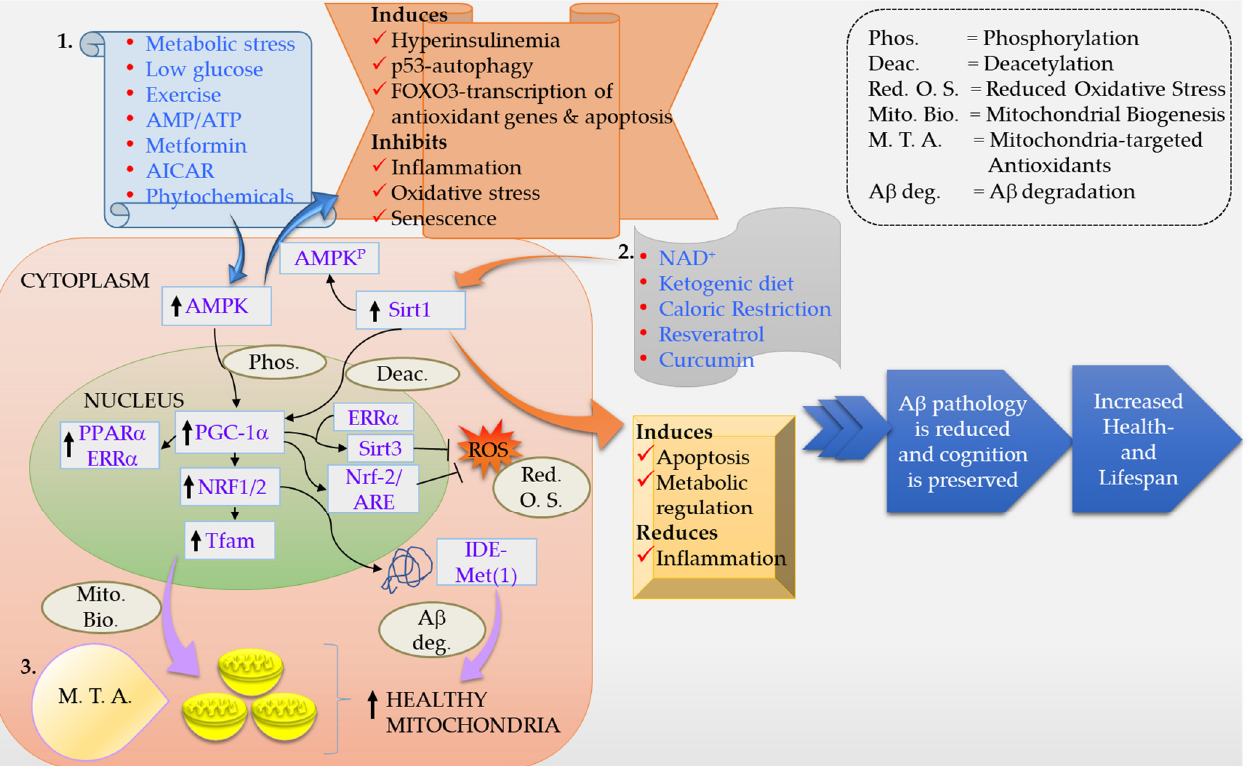
Figure 2. Schematic representation of various factors and processes involved in the mechanism of neuroprotection in AD. Various therapeutic approaches and physiologic and extracellular signals are shown in boxes 1 and 2 that induce the activity of AMPK and Sirt1, respectively. Downstream changes are reflected in expression of PGC-1 α , NRF1, NRF2, Tfam, Sirt3, etc. IDE-Met(1) metabolizes mitochondrial A β and is regulated by the PGC-1 α -NRF1 pathway. As a result of the activation of the AMPK-PGC-1 α -NRF1-Sirtuins cascade, mitochondrial biogenesis, autophagy, A β degradation, and metabolic regulation are induced, and oxidative stress is reduced. A direct delivery of therapeutic molecules is now achievable, owing to the nano-carriers and mitochondria-targeted antioxidants. All of these approaches have shown success in various clinical and preclinical studies and hold promise for the future.